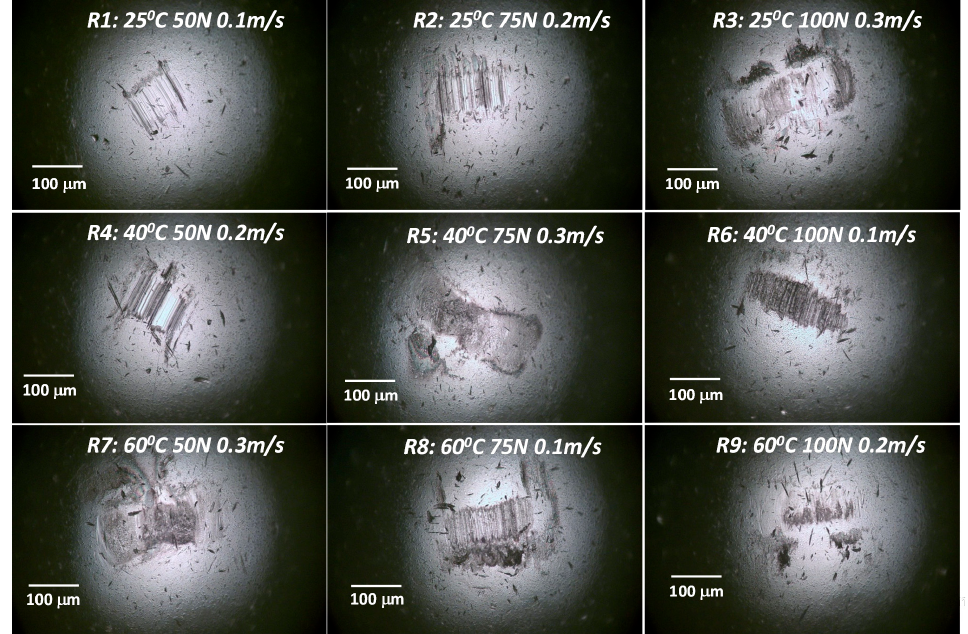
Figure 7. Optical images of the counterface ball after the wear tests conducted at different conditions according to the L 9 OA.